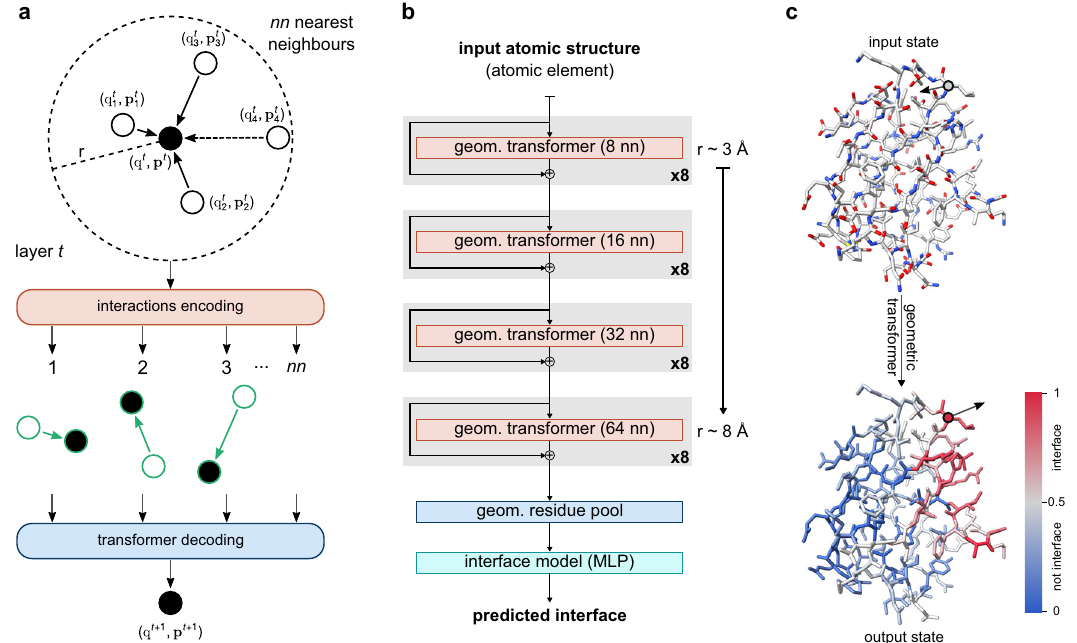
Fig.1|OverviewofthePeSTomethod.a Primarygeometrictransformeractingon the scalar and vectorial state of an atom at layer t . The interactions between the central atom and the nearest neighbors are encoded. A transformer is used to decodeand fi lterthe interactionsinformationand tocompute thenewstateofthe central atom (Supplementary Algorithm 1). b The architecture of PeSTo for the prediction of interaction interfaces. The model is composed of multiple layers of